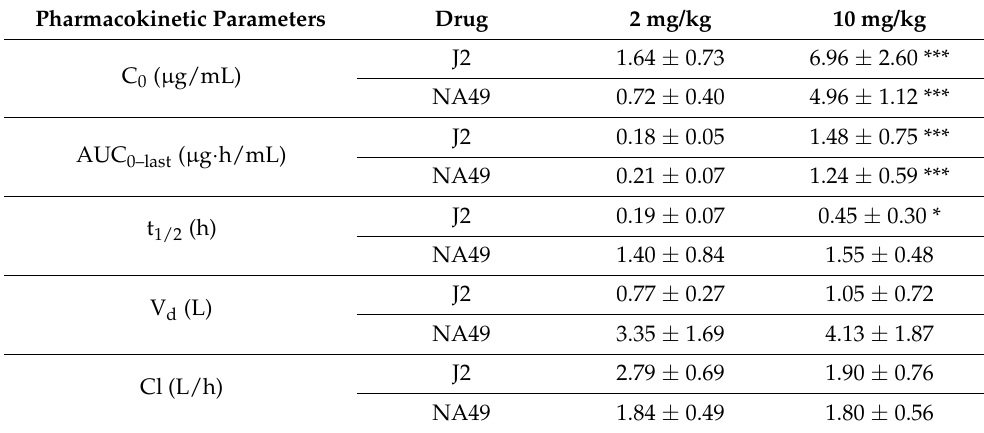
Figure 2. Mean plasma concentration–time profiles of J2 and NA49. ( A ) J2 and ( B ) NA49 were intravenously injected into rats. Bars represent S.D. ( n = 5–9). ( • ) 2 mg/kg; ( ) 10 mg/kg. (cid:35) Table 4. Mean pharmacokinetic parameters following IV injection in rats.